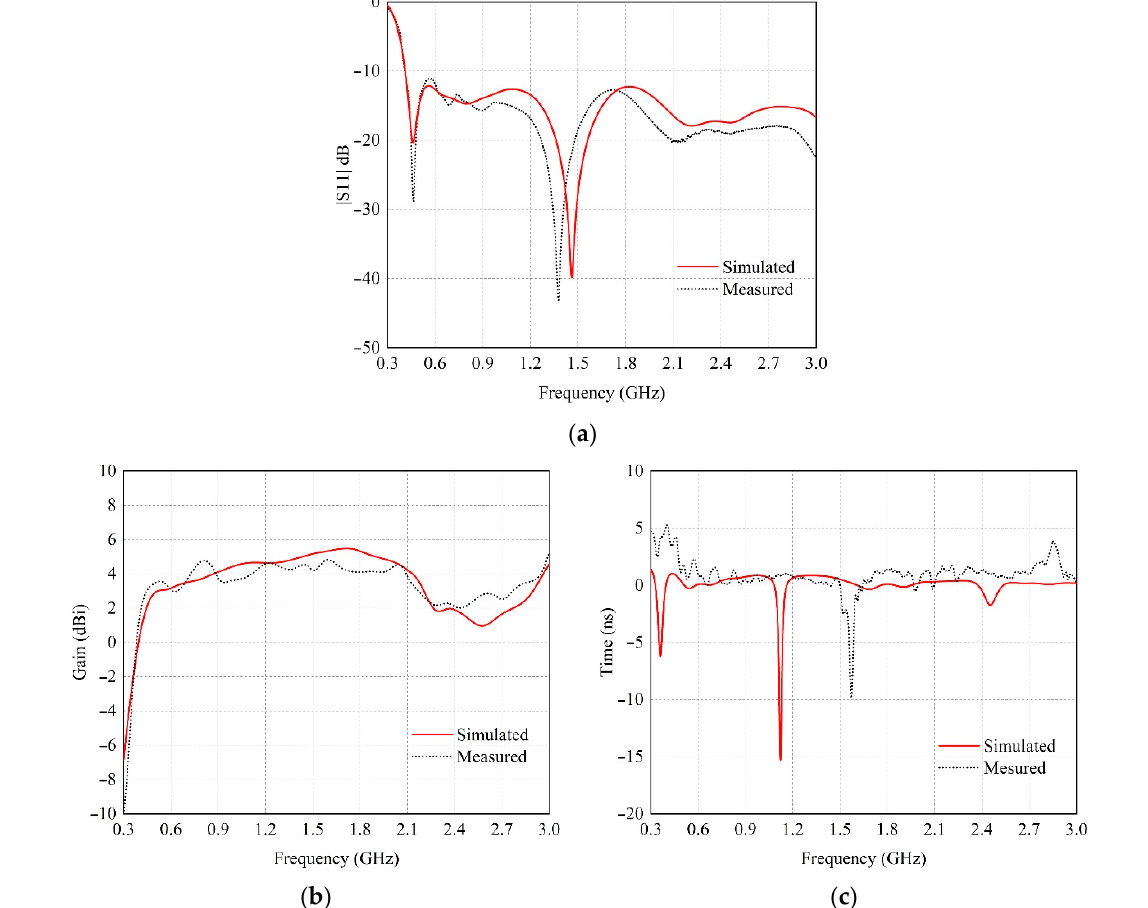
Figure 4. The simulated and measured: ( a ) | S 11|; ( b ) gain; ( c ) group delay.